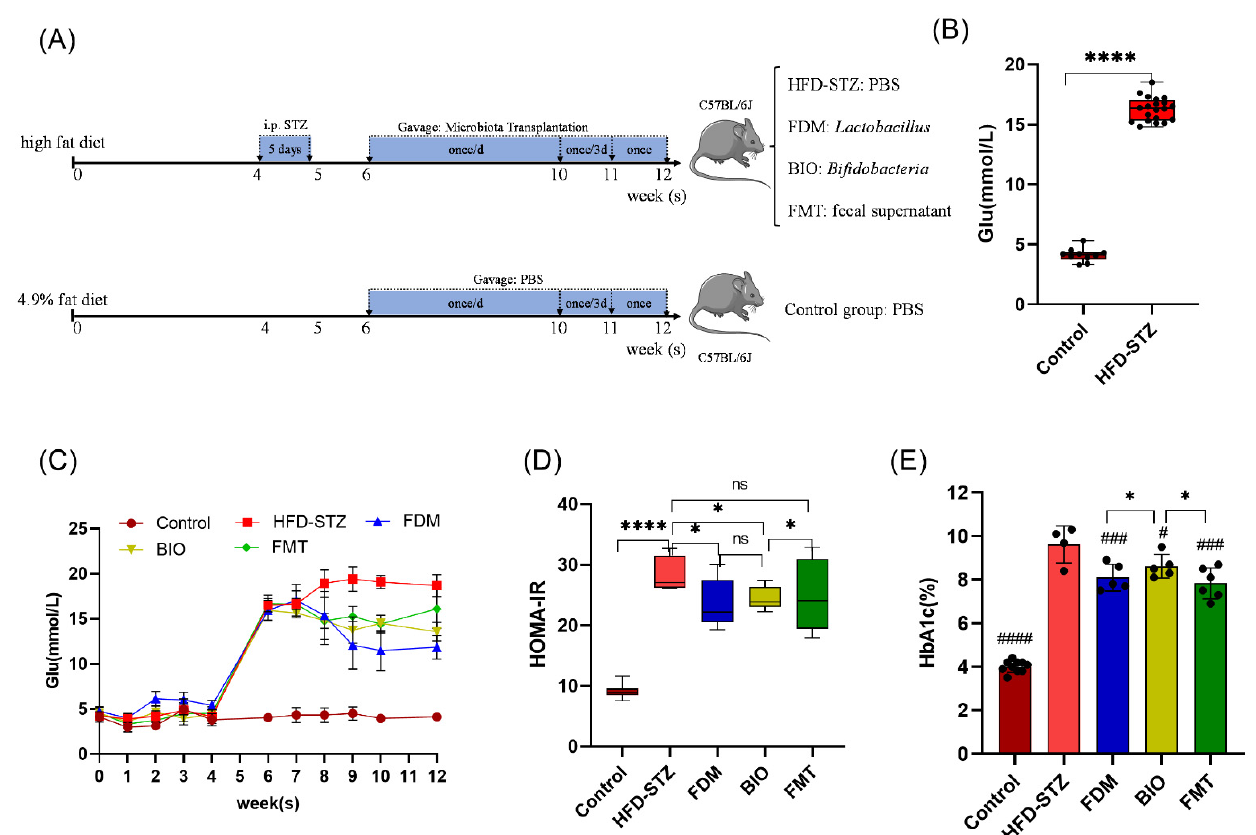
Figure 2. Glucose-lowering effect of bacterial transplantation into mice models of type 2 diabetes. ( A ) Flow chart of the model development. ( B ) Fasting blood glucose value of the mice after modeling; the blood glucose levels increased significantly after modeling ( p < 0.0001). ( C ) Change curve of fasting blood glucose of mice in each group during the bacterial transplantation process; the FDM group had the most remarkable decrease in blood glucose. ( D ) Insulin resistance index value, HOMA-IR = FBG*FINS/22.5, FBG (Fasting blood glucose), FINS (fasting insulin). ( E ) Levels of hemoglobin A1c (HbA1c) after intervention. The FDM, BIO and FMT groups showed different degrees of reduction, and the difference was statistically significant ( p < 0.05). high fat diet, 60% Kcal; i.p. STZ, intraperitoneal injection of streptozotocin; HFD-STZ, type 2 diabetes (T2D) group, gavaged with PBS; FDM, fecal dominant microbiota group, the group which received Lactobacillus transplantation; BIO, the group which received Bifidobacterium transplantation; FMT, fecal microbiota transplantation group, gavaged with fecal supernatant; control, 4.9% fat diet group, gavaged with PBS. The number of mice in each group at the end of the experiment was as follows: control ( n = 10), HFD-STZ ( n = 4), FDM ( n = 5), BIO ( n = 5), and FMT ( n = 6). * ( p < 0.05), **** ( p < 0.0001), and ns ( p > 0.05) represents the one-way ANOVA analysis with each group, # ( p < 0.05), ### ( p < 0.001), and #### ( p < 0.0001) represents the one-way ANOVA analysis with the HFD-STZ